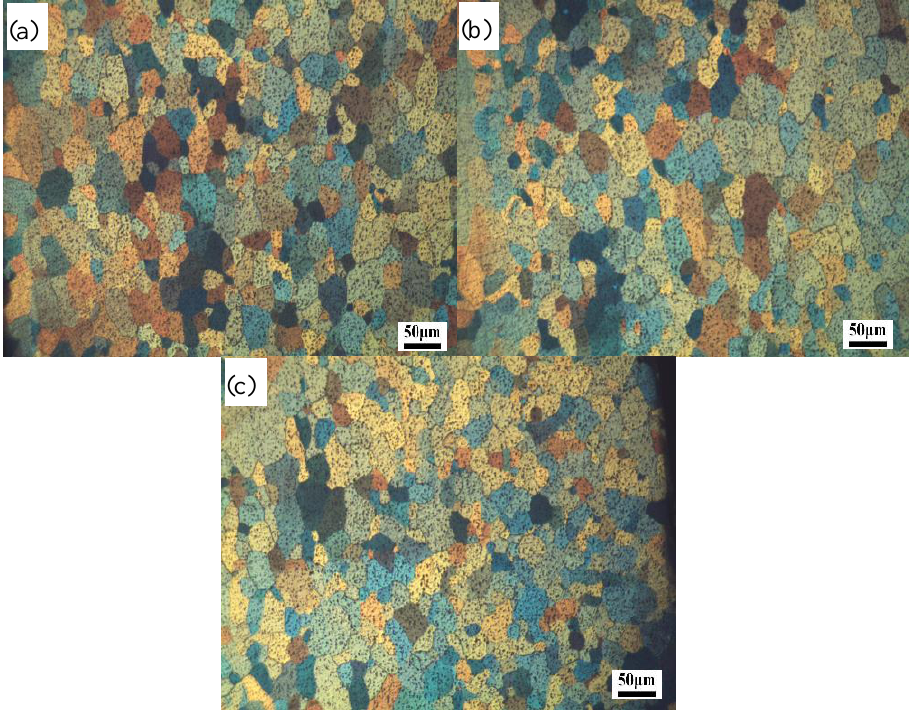
Figure 22. Optical micrographs in different observation points of ( a ) 1#, ( b ) 2#, and ( c ) 3# on the profile.